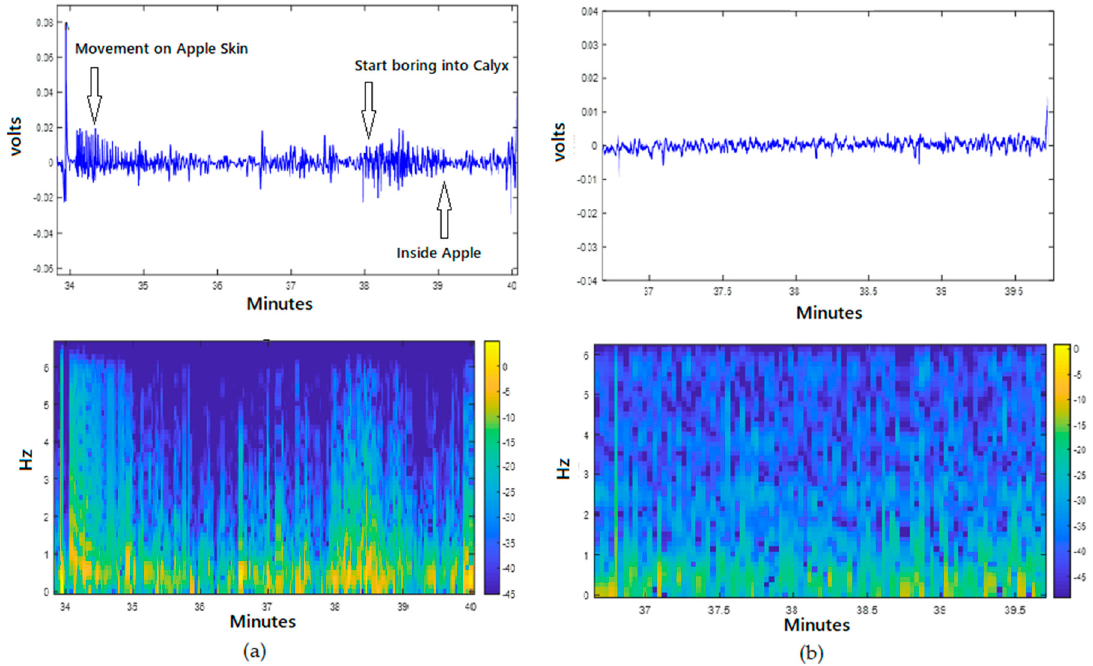
Figure 6. Acoustic signals from ( a ) infested versus ( b ) non-infested Apple samples [105] .